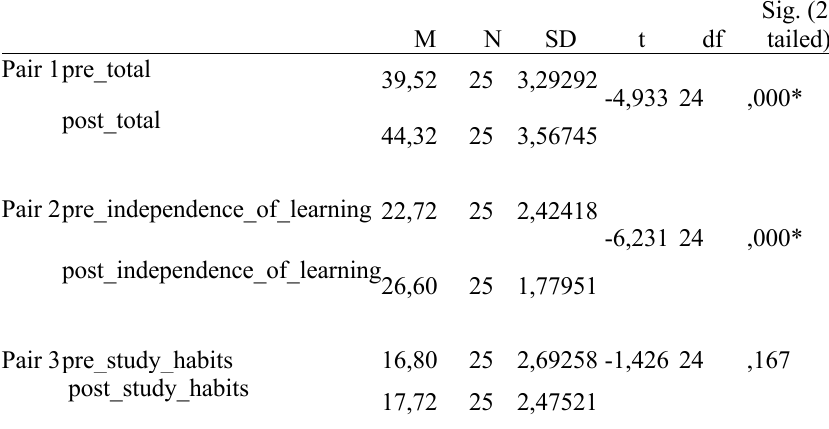
Table 1. The change in the autonomy level of the